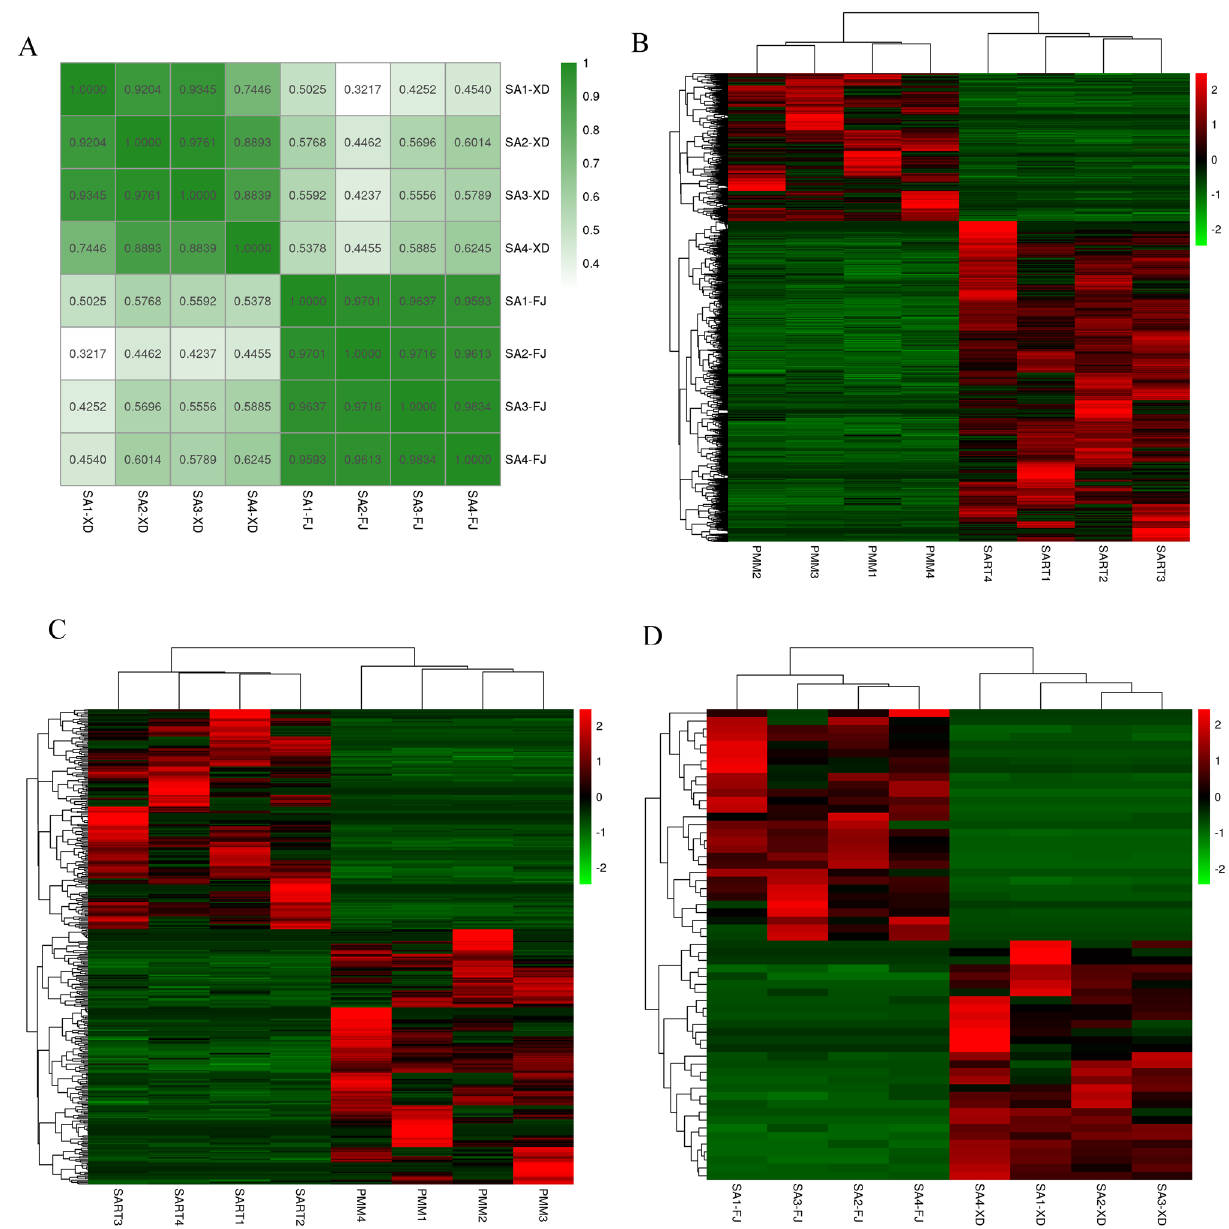
Figure 3. Heatmaps of sample correlation and differentially expressed RNAs between PMM and SART. ( A ) Sample consistency. Dark green indicates a high correlation. ( B ) Heatmap for DE-mRNA. ( C ) Heatmap for DE-lncRNA. ( D ) Heatmap for